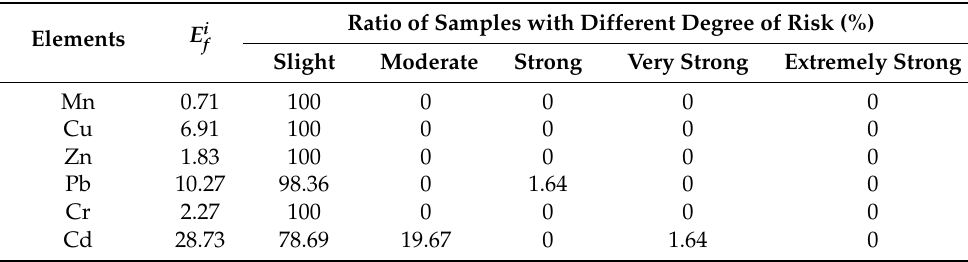
Table 4. Ecological Risk index of PHMs in the soils of